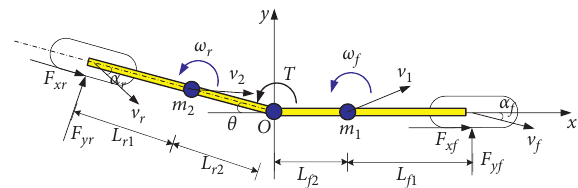
Figure 1: Single-track model of an articulated